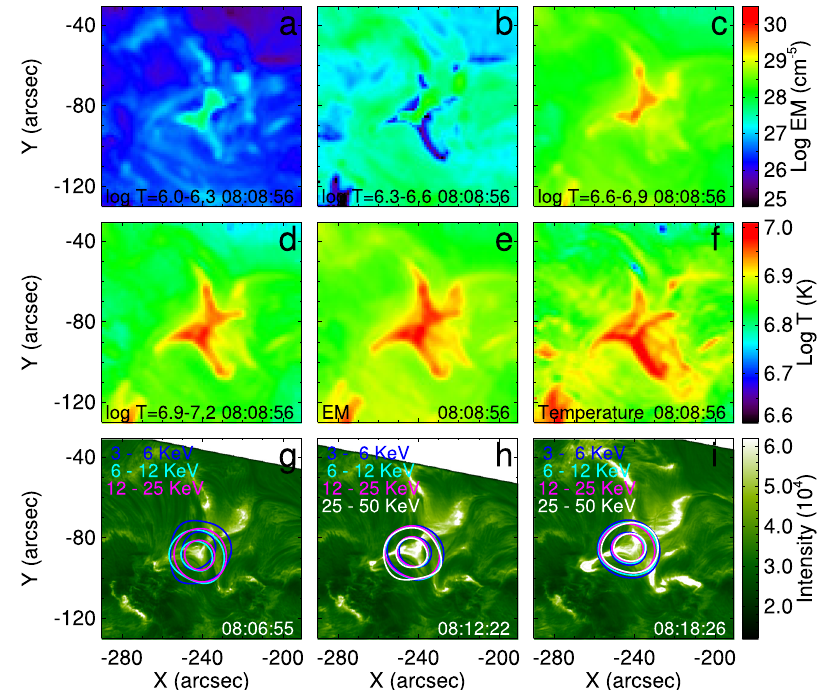
Fig. 6 Emission measure and temperature maps and H α images with RHESSI X-ray sources superimposed. a – d DEM maps in four temperature ranges. e Total emission measure. f Temperature of the reconnection region derived from six AIA wavelengths. g – i H α images with RHESSI hard X-ray sources superimposed. The levels of the contours are at 50% and 80% of the peak values in the 3 – 6 (blue), 6 – 12 (cyan), 12 – 25 (pink), and 25 – 50 (white) keV bands. Source data are provided as a Source Data fi